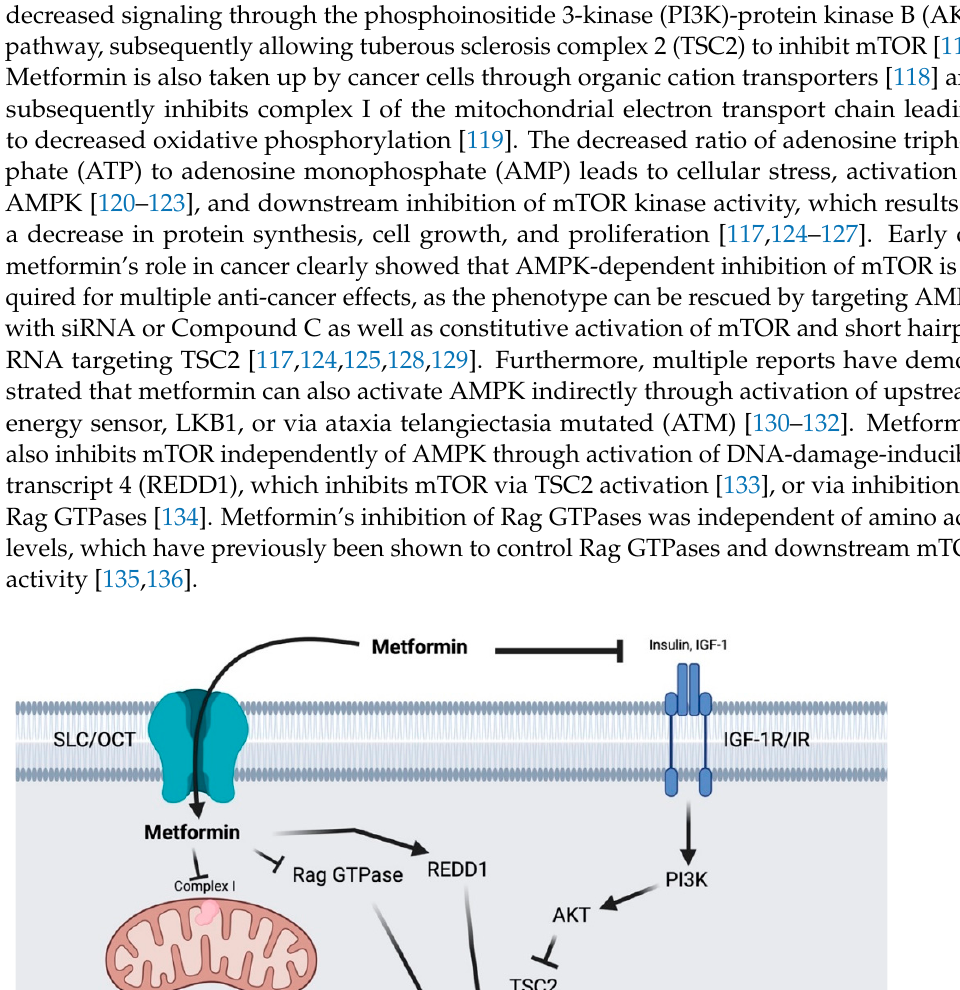
Figure 1. Overview of metformin’s systemic effects on tumor growth. Metformin’s activation of the LKB1/AMPK pathway in hepatocytes and adipocytes, and in the pancreas, leads to reduced blood glucose and insulin availability, respectively. Decreased glucose and insulin availability can slow tumor growth and progression. LKB1: Liver Kinase B1, AMPK: AMP-Activated Protein Kinase. Cre- ated in BioRender.